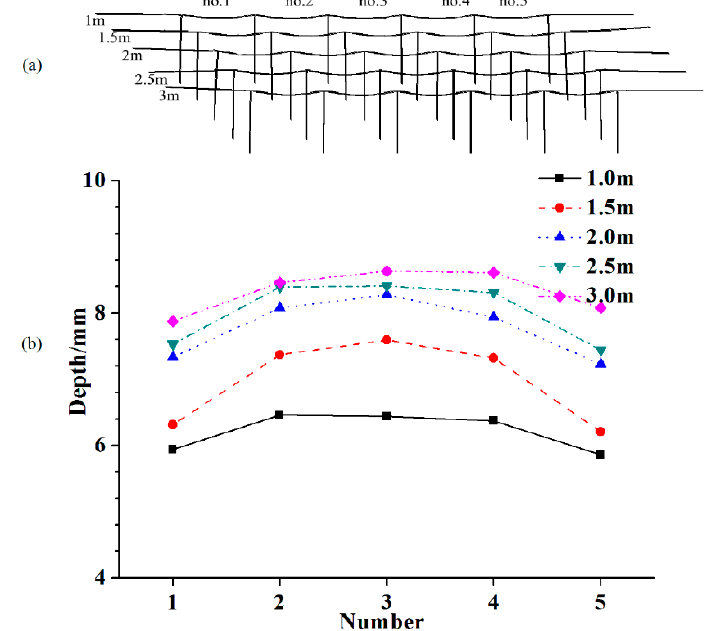
Figure 26. Deformation and maximum depth at different drop heights. ( a ) Deformation of the middle section of the plate frame. ( b ) Maximum depth measured in simulation.